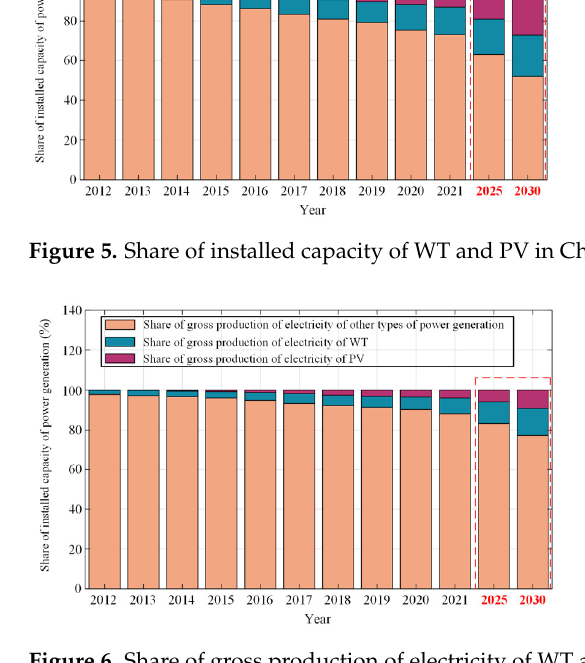
Figure 6. Share of gross production of electricity of WT and PV in China.